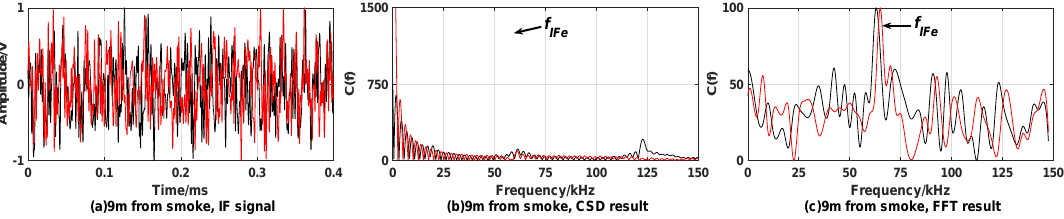
Figure 6. Simulation results when expected distance is 9 m with Smoke interference but no target. When fuze is 9 m away from smoke, ( a ) is time domain waveform of the IF signal; ( b ) is the processing result of CSD algorithm; ( c ) is the processing result of the FFT algorithm.